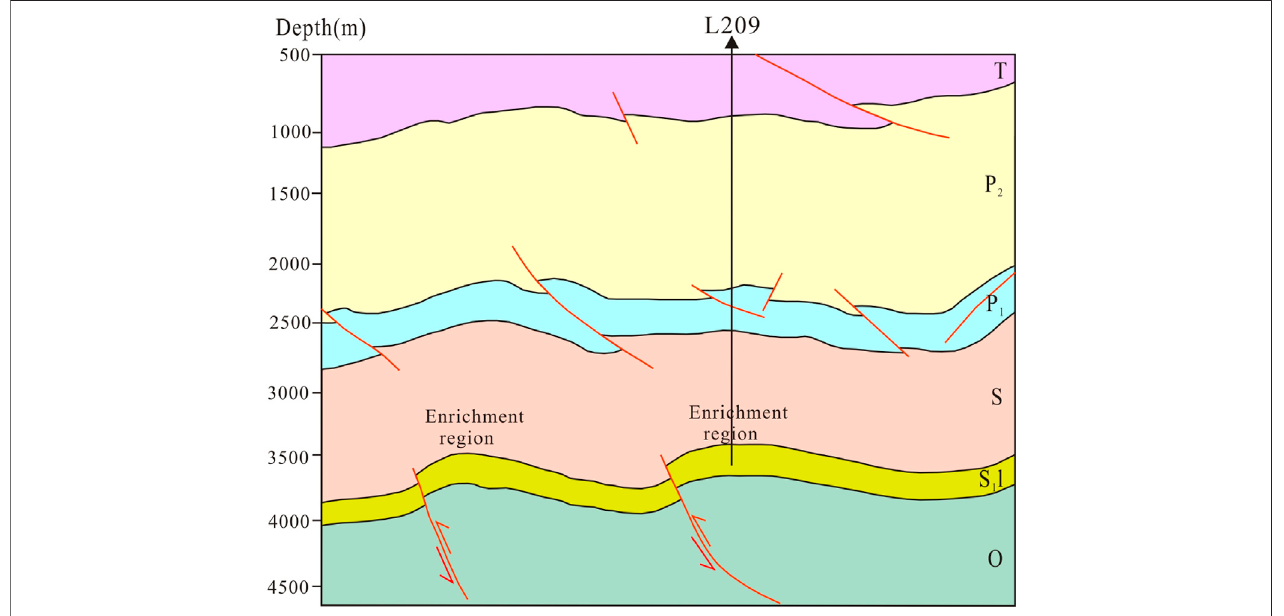
FIGURE 8 | High-angle reverse fault combination in Luzhou